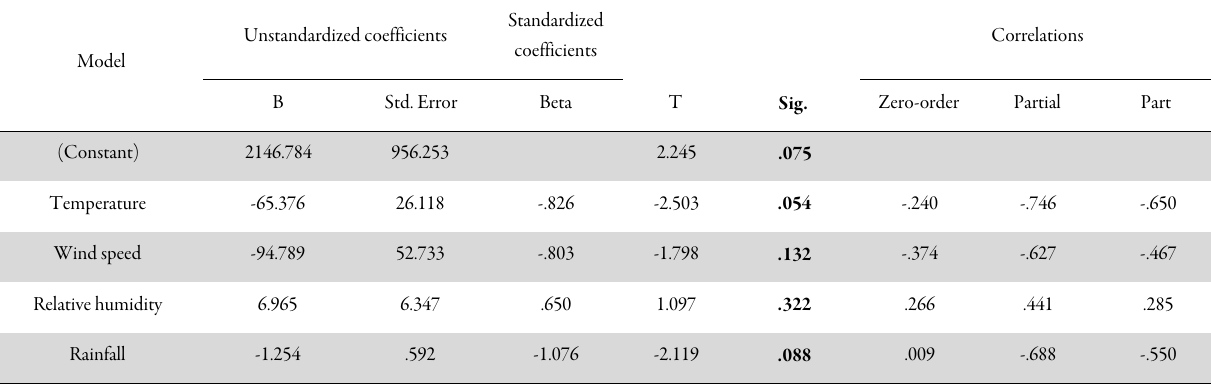
Table 6. Correlation coefficients showing the significance levels in the correlation between monthly pollen concentrations and values of mean monthly meteorological parameters at the study site in Kaduna State at 95% confidence interval (P <